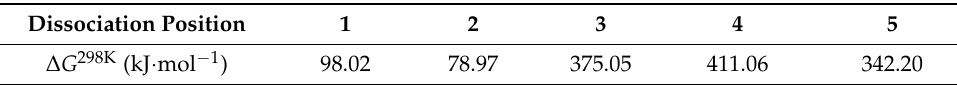
Figure 4. The bond-breaking positions of hydrogen in ( a ) syringic acid, ( b ) erucic acid, and ( c ) natural rubber repeat unit. Table 2. The hydrogen dissociation energies for SA, EA, and NR.